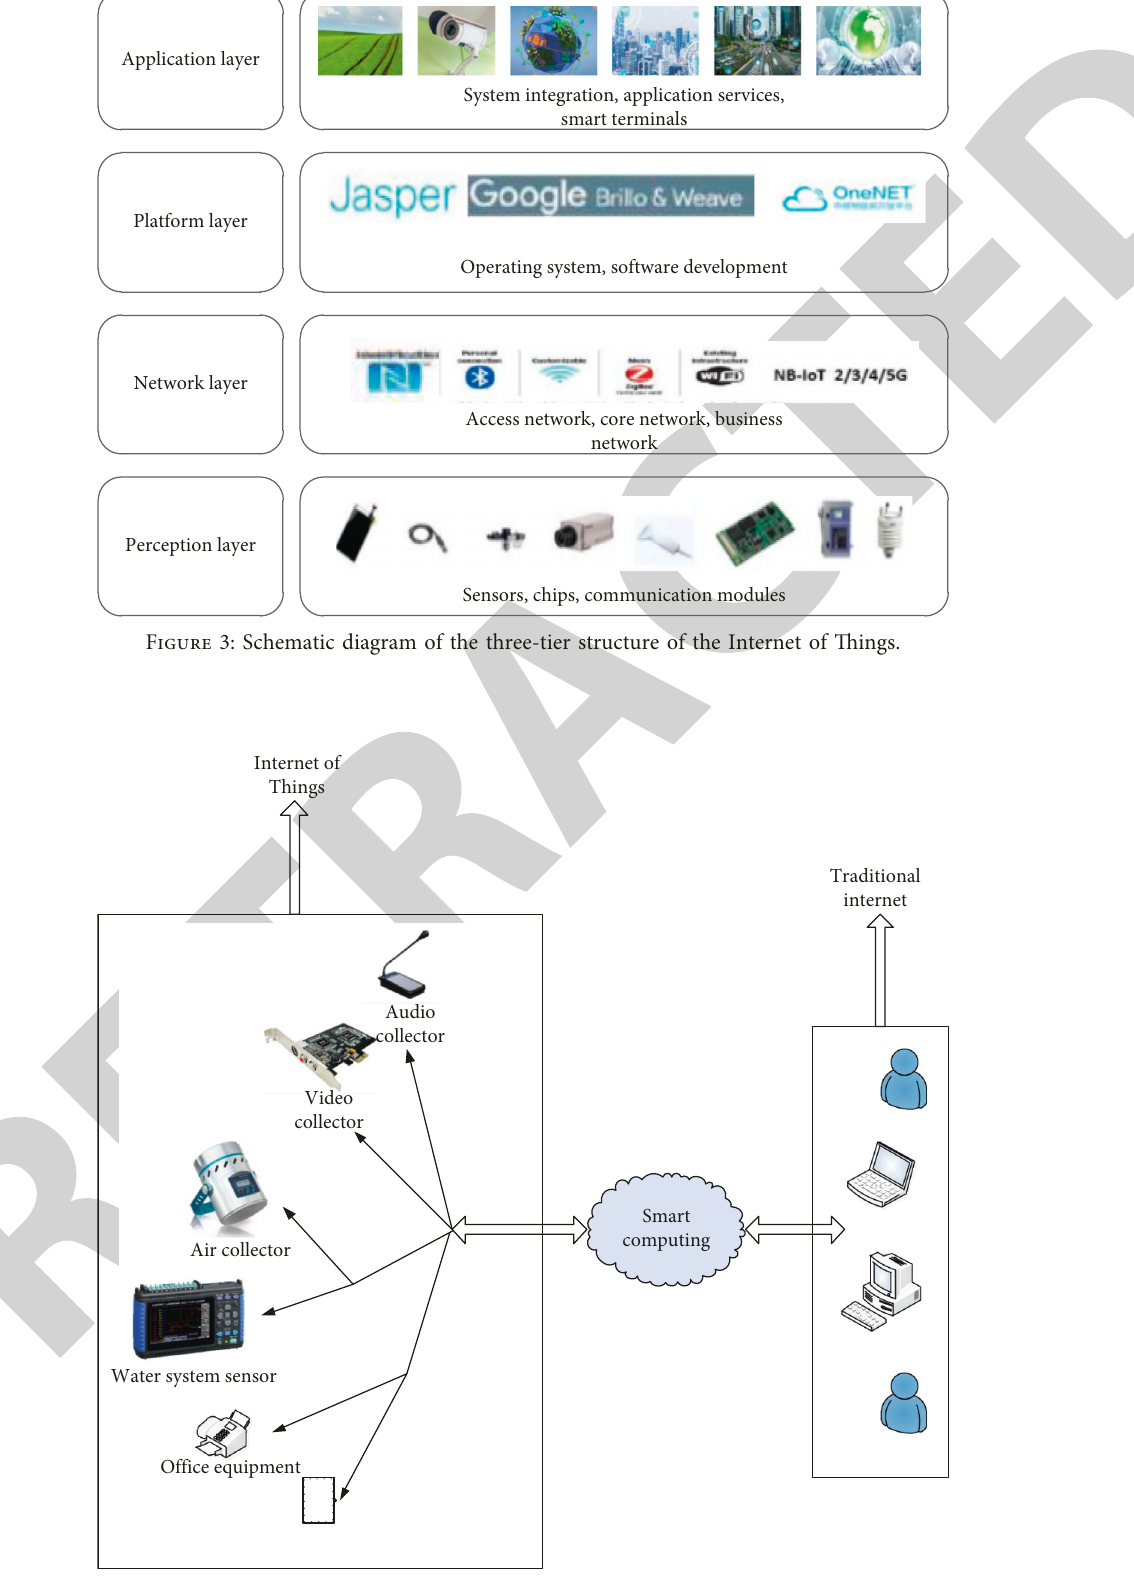
Figure 4: Schematic diagram of the Internet of Things and intelligent